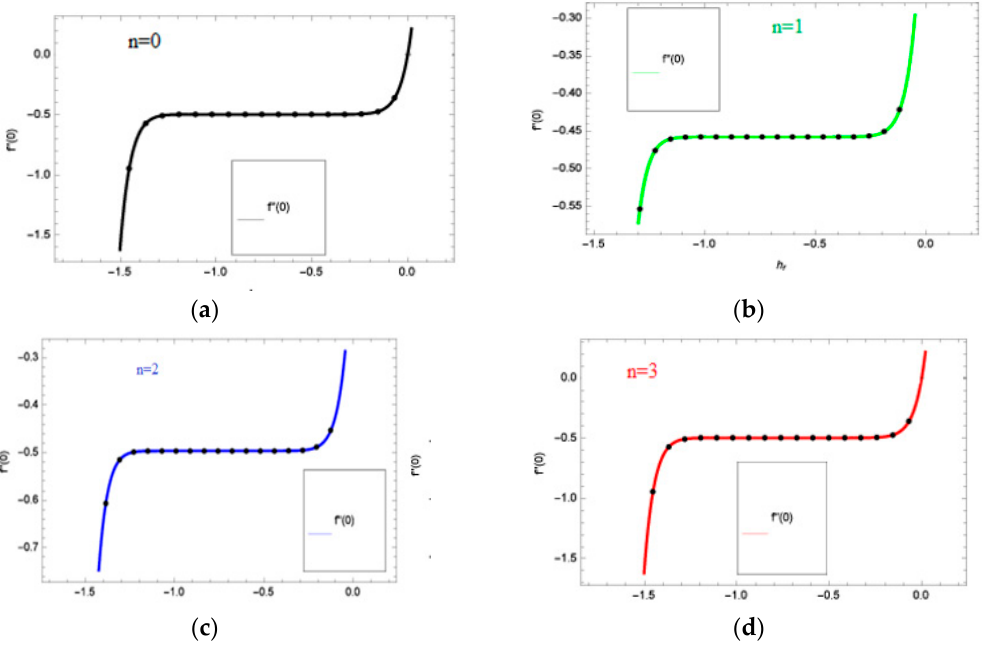
Figure 2. The h -curve graphs for velocity profile for 𝑛 = 0,1,2,3 where 𝛽 = 0.5, 𝜉 = 𝑆𝑡 = 𝑀 = 0.1,𝜀 = 1